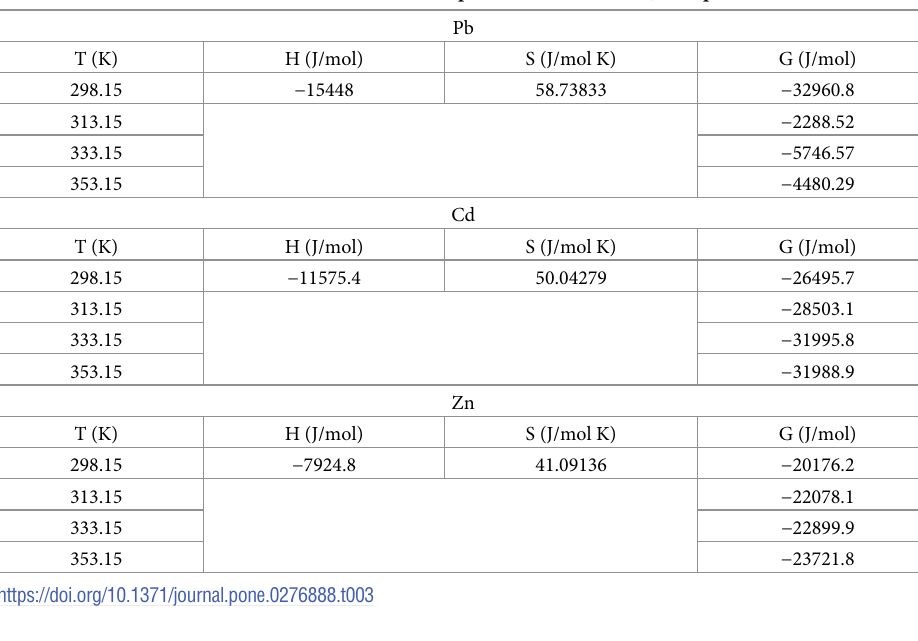
Table 3 shows the thermodynamic parameters of Zn +2 , Pb +2 , and Cd +2 adsorption onto SnCaAl O nanoparticles at varied temperatures. The Δ H and Δ S changes were calculated as 2 3 the slope and intercept of the linear plot ln Kc against 1 /T (S3 Fig) [77]. From the Van’t Hoff equation Δ H, Δ S, and Δ G are calculated using Eqs (5), (6) and (7). The negative values were